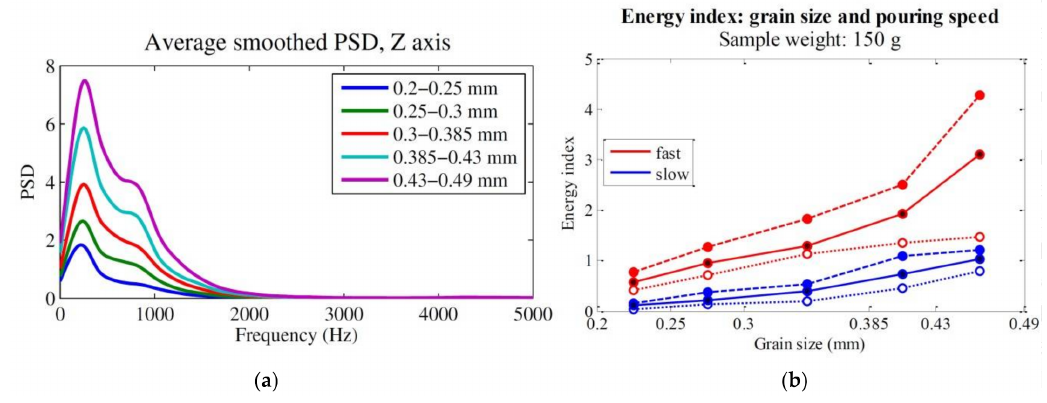
Figure 9. Example of indirect flow measurement of solid particles: ( a ) power spectral densities, ( b ) energy index.